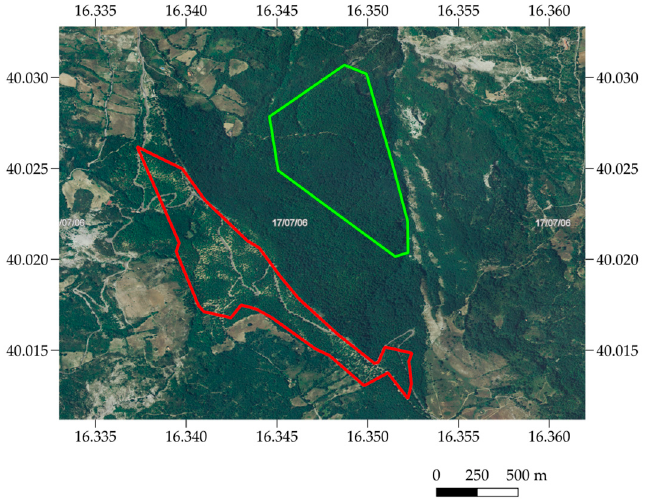
Figure 3. ( a ) D forest (~54 ha) in Gorgoglione; ( b ) ND forest (~547 ha) in Accettura-Pietrapertosa. Background: Orthophoto, June 2006 [46].